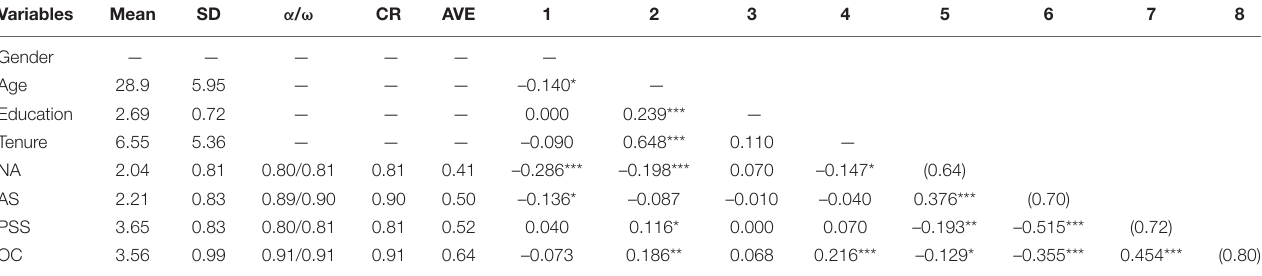
TABLE 1 | Descriptive statistics and correlations.